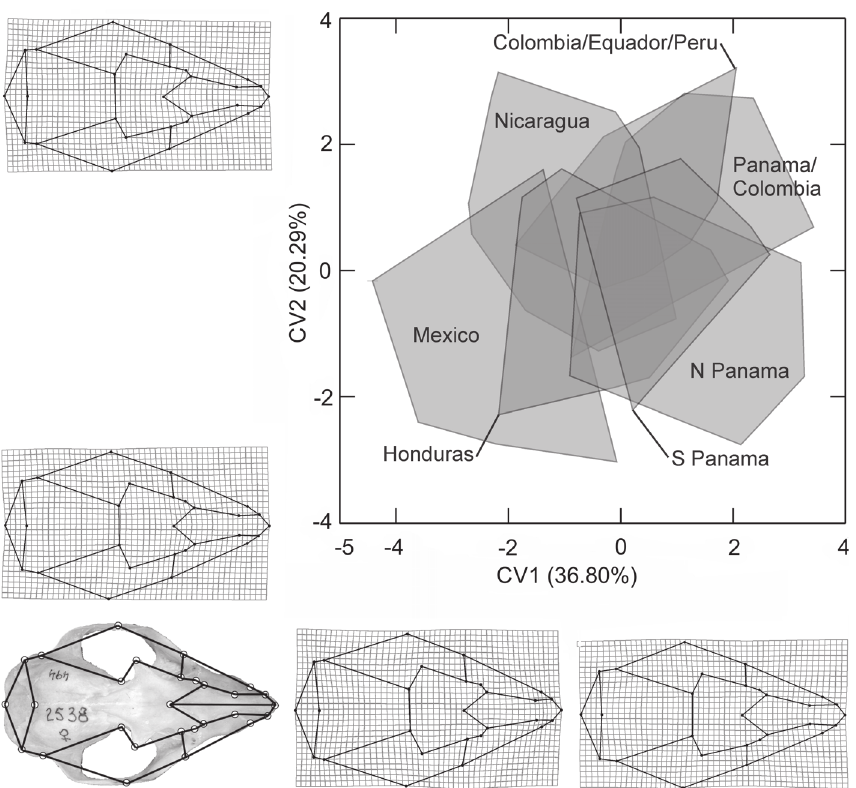
Figure 4. Canonical Variates Analysis on shape variables (partial warps and uniform components) of the skull in dorsal view of Caluromys derbianus , using localities as grouping factors, and percentage of variance explained by the first two CVs. Only the convex hulls for each population are shown. Grids indicate deformation associated with the extremes of each CV, from a multivariate regression of shape variables onto CV scores. Overlap for all other views are very similar, therefore only the dorsal view of the cranium is